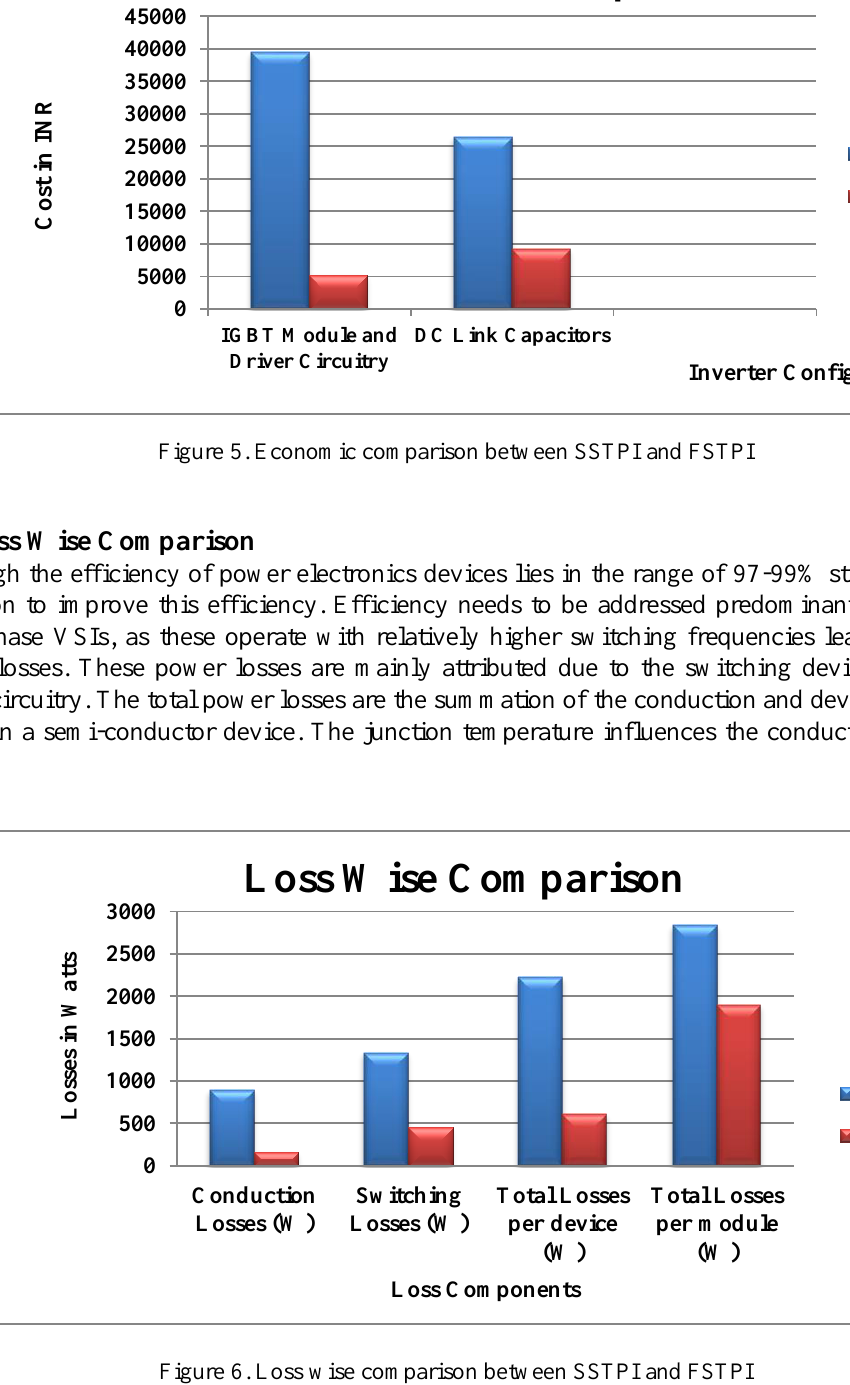
Figure 6. Loss wise comparison between SSTPI and